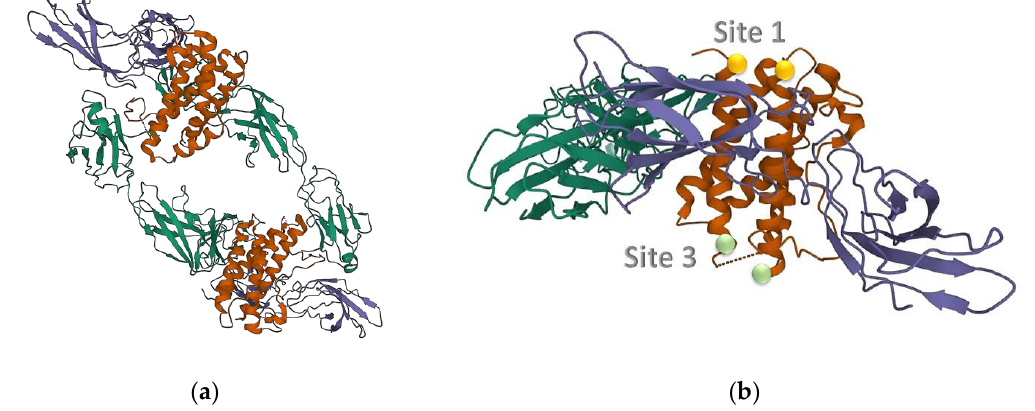
Figure 1. Quaternary structures of IL-6, cytokine IL-6 (orange) complexes with the receptor IL-6R, α -chain, (indigo) and the glycoprotein gp-130, β -chain (green). ( a ) Hexameric form; ( b ) Trimeric form; the contact positions named Site 1 and Site 3 are represented by small balls. (PDB entry: 1p9m) [38,43]. Various therapeutic MAbs (sarilumab and siltuximab, for instance) are currently used